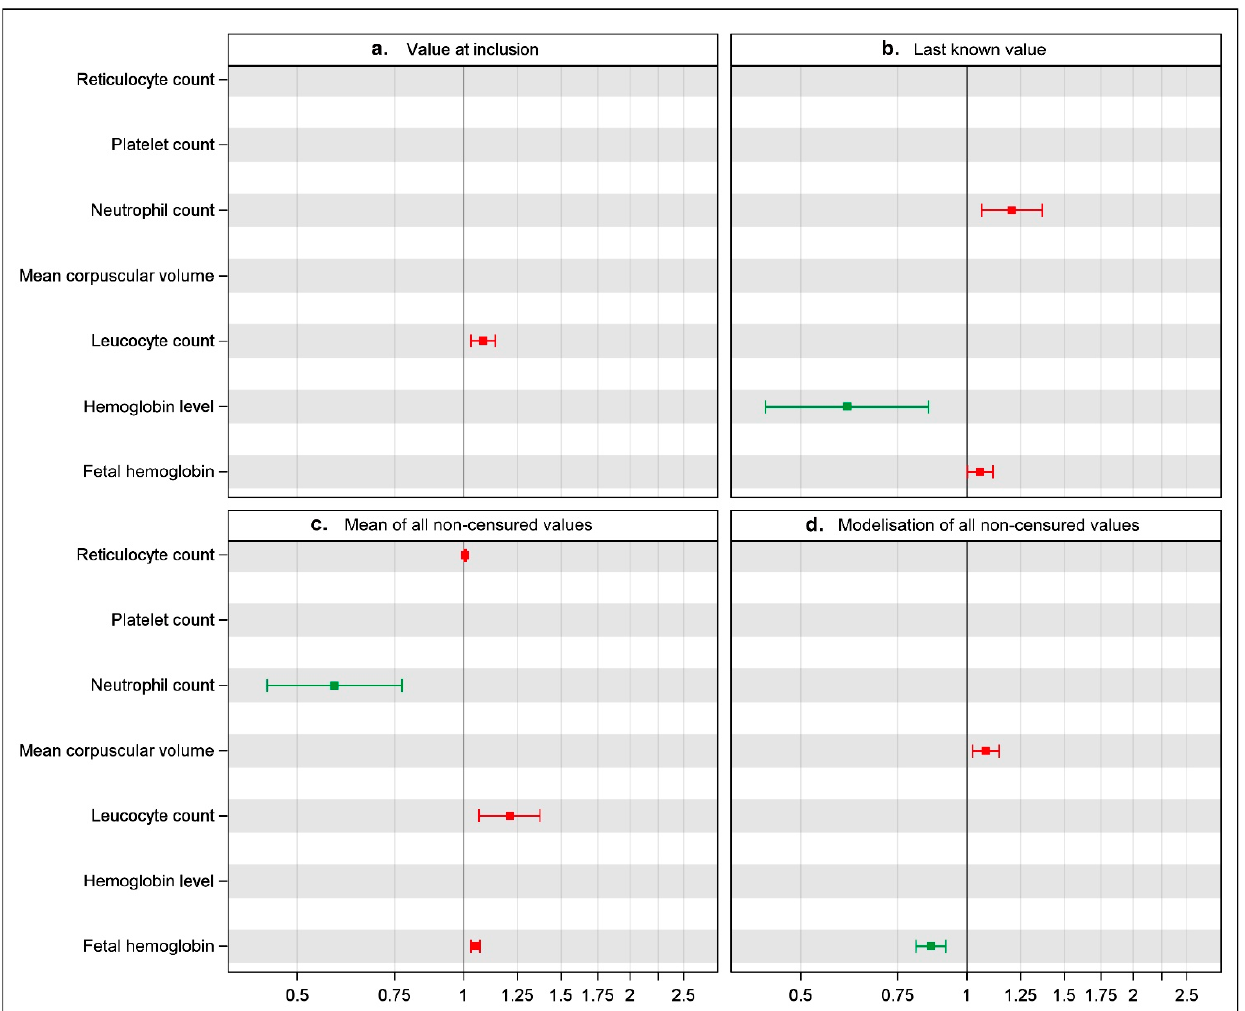
Figure 1. Illustration of results obtained according to the four methods used to enter the variables in the cox model studying the relationship between the biological parameters and the occurrence of cerebral vasculopathy.